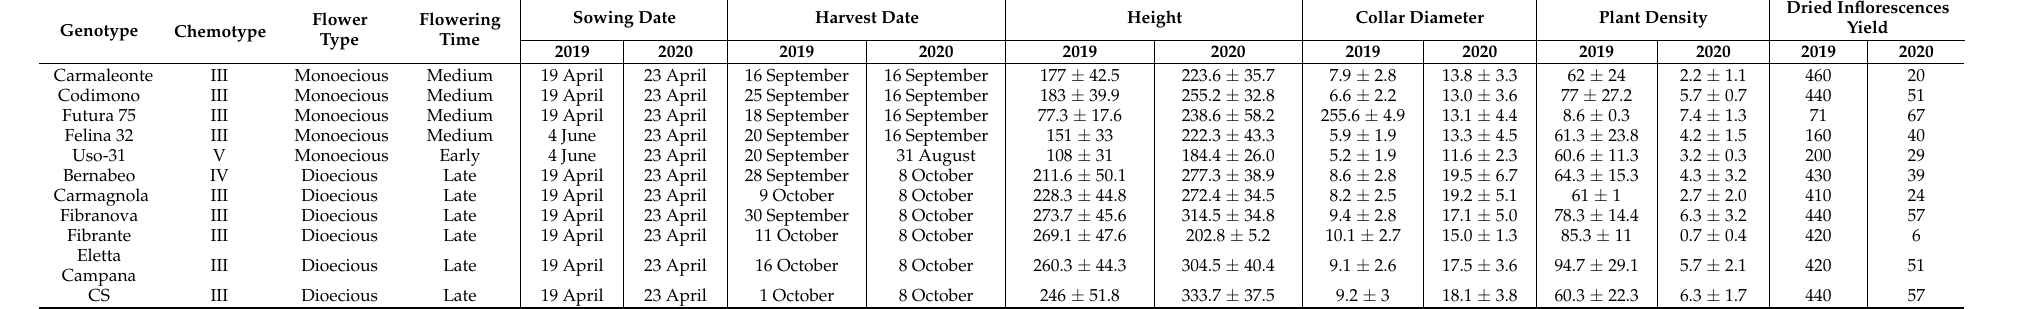
Table 1. Agronomic trial data from the years 2019–2020. Height is expressed in cm, the diameter at the collar in mm, the density as number of plants/m 2 , and the dried inflorescences yield is g/m 2